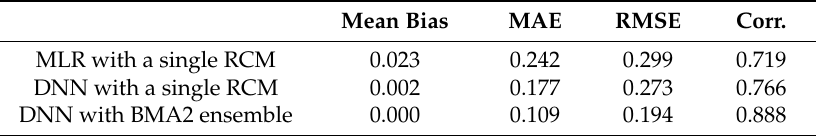
Figure 5. Error statistics of BMA and BMA2 for the four input variables. Accuracy of BMA2 was improved markedly with a correlation coefficient of approximately 0.97. Table 6. Averages of the validation statistics of the prediction models for sea ice